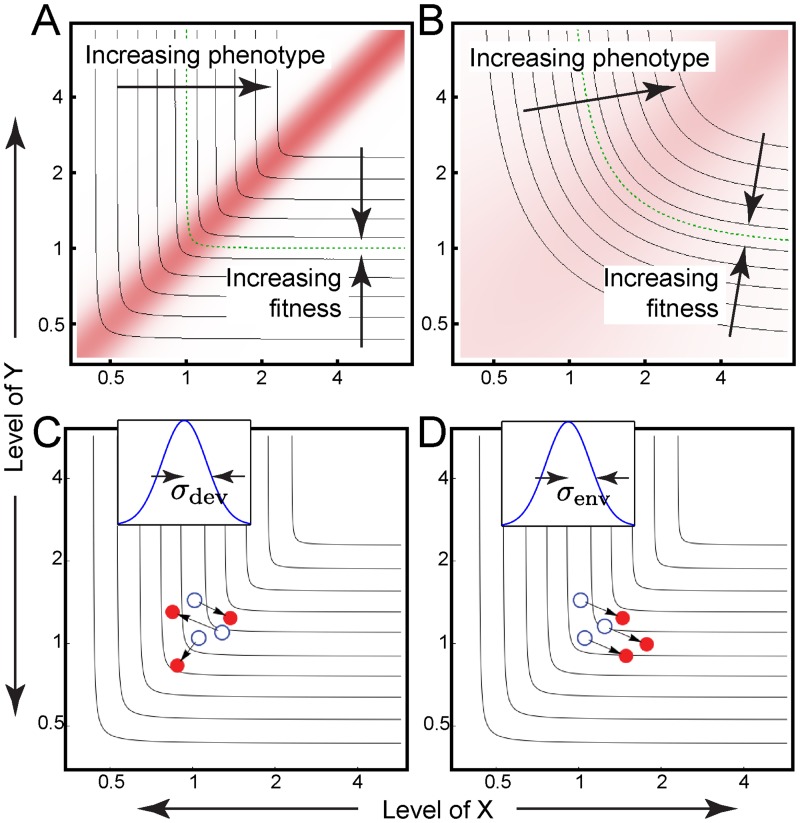
The generalized LP model.(A, B) Epistasis landscape (red shading) and common contours of the phenotype and fitness landscapes (black lines) for k = 0.005 (A) and 0.5 (B). (C, D) Schematic illustrating how phenotypic noise can be viewed as random perturbations of the input values, transforming nominal values (white) into effective values (red). The magnitudes of the perturbations are drawn from a Gaussian distribution defined on the natural logarithm of gene levels (insets). This sampling process is repeated for each individual independently (developmental noise; C) or performed once for all individuals (environmental noise; D); see Methods.